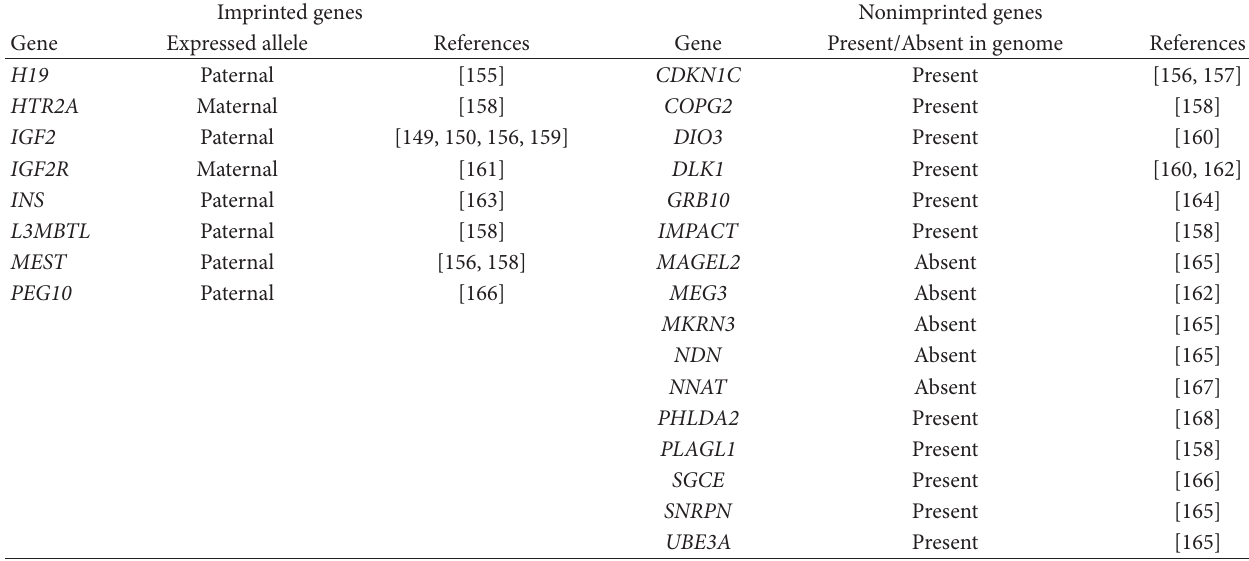
T 2: Orthologues of eutherian imprinted genes and their imprint status in